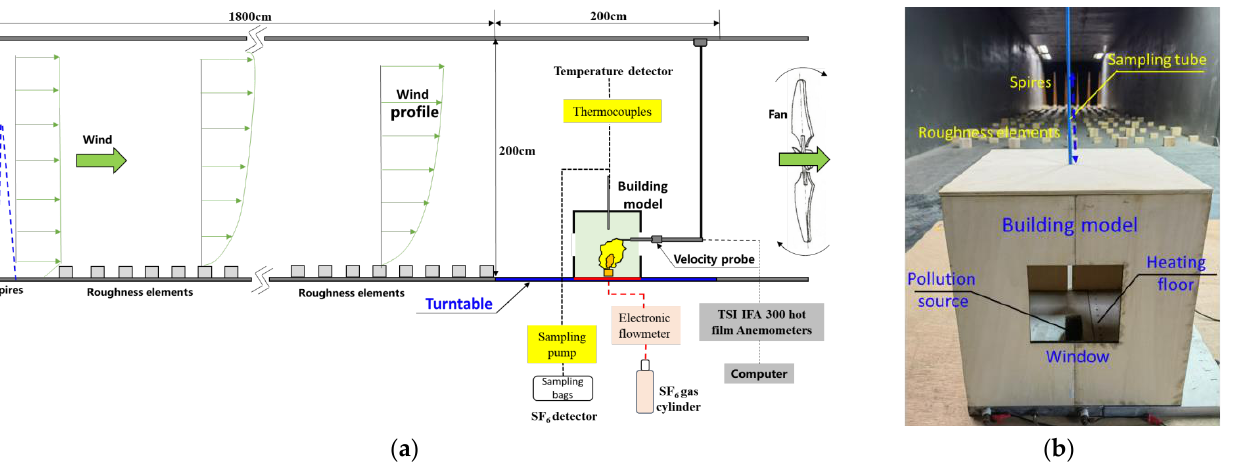
Figure 4. Wind-tunnel experimental model and setups. ( a ) Wind tunnel experimental setups. ( b ) Building model.